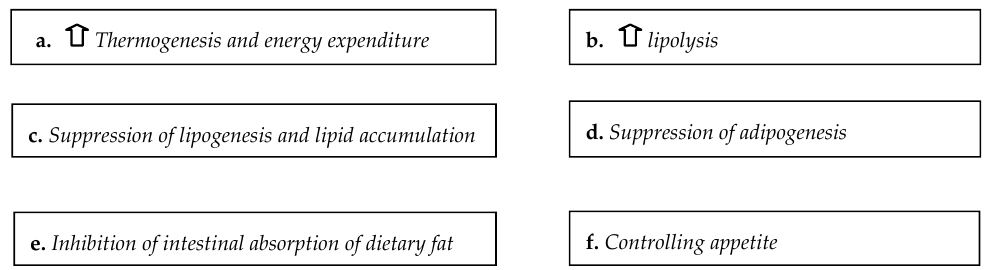
Figure 1. Possible mechanisms of ginger effect on body weight management. Table 7. Human intervention clinical studies about the possible effects of ginger on body weight control, obesity, and its metabolic consequences